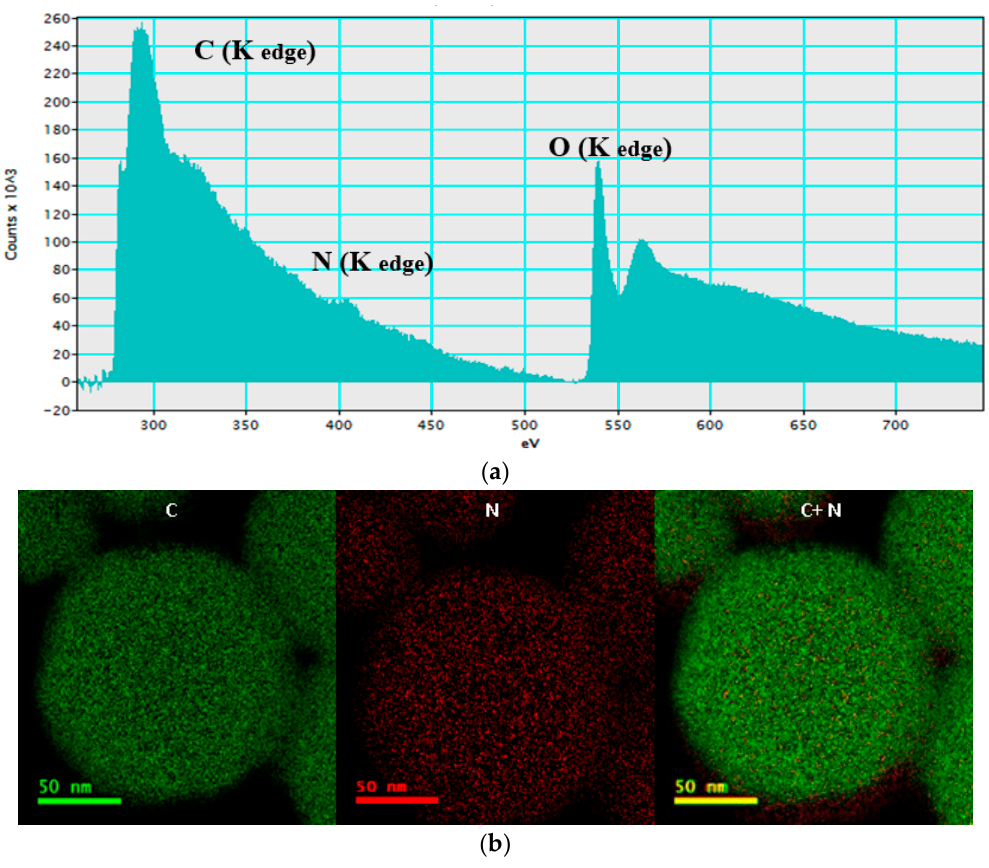
Figure 6. ( a ) Electron energy loss spectroscopy (EELS) spectra of functionalized with flufenamic acid (FFA) (MCM-41/AP-FFA), and ( b ) energy-filtered transmission electron Mmcroscopy (EFTEM) images obtained by TEM.